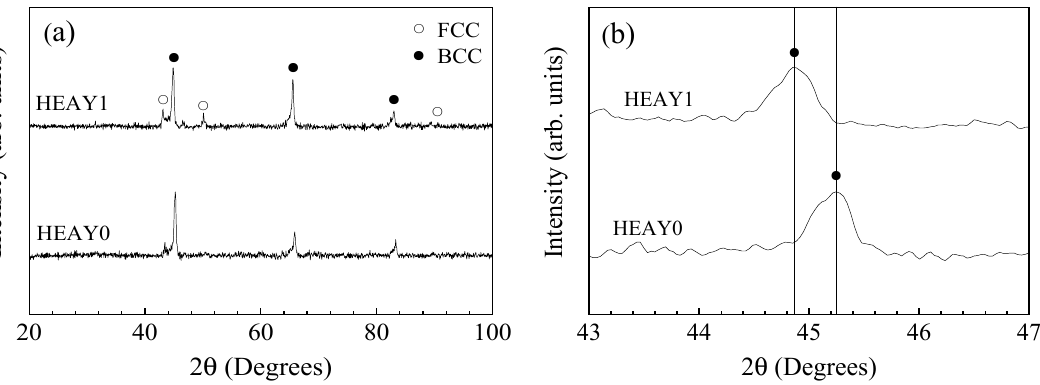
Figure 1. X-ray diffraction (XRD) diffraction patterns for the laser cladding high entropy alloy (HEA) coatings without and with Y 2 O 3 addition ( a ); An enlarged picture of the main peak of BCC phase ( b ).